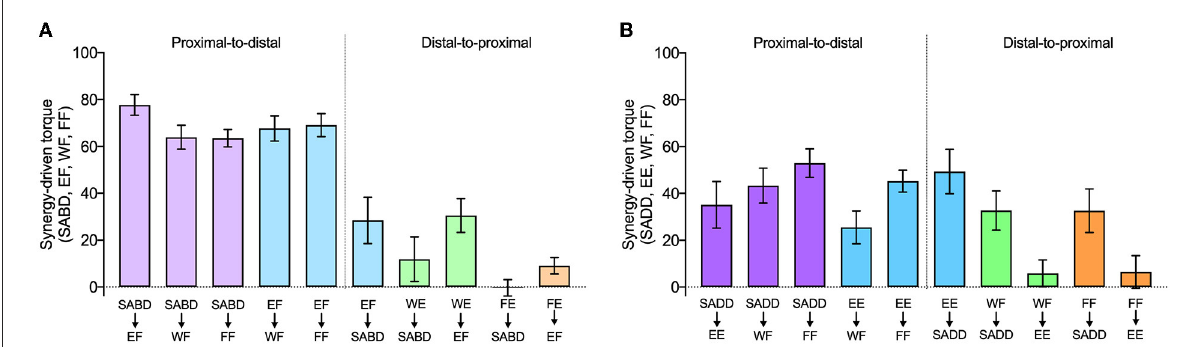
FIGURE4 The strength of proximal-to-distal vs. distal-to-proximal elicitation of the flexion and extension synergies. Group mean ± SEM synergy-driven torques (the same as in Figure 3) are shown for each joint combination and direction, as indicated on the x-axis. The top row of labels is the primary torque direction, and the bottom row of labels is the secondary torque direction. Data from primary torque directions that elicited the flexion synergy are shown in (A) , and data from primary torque directions that elicited the extension synergy are shown in (B) . Note that attempts to generate WE and FE (i.e., when they were the primary torque directions) instead resulted in the production of WF and FF, respectively.